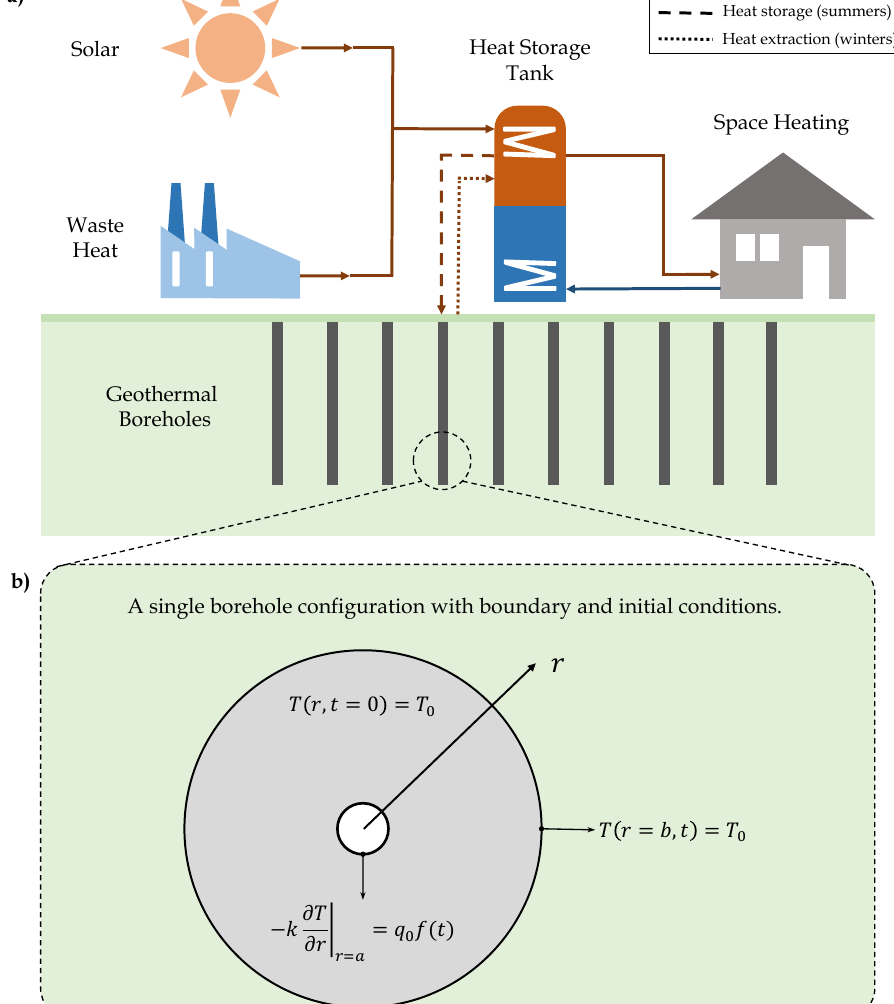
Figure 1. Schematic diagram of ( a ) a S-GBS or W-GBS; and ( b ) a single borehole system with boundary and initial